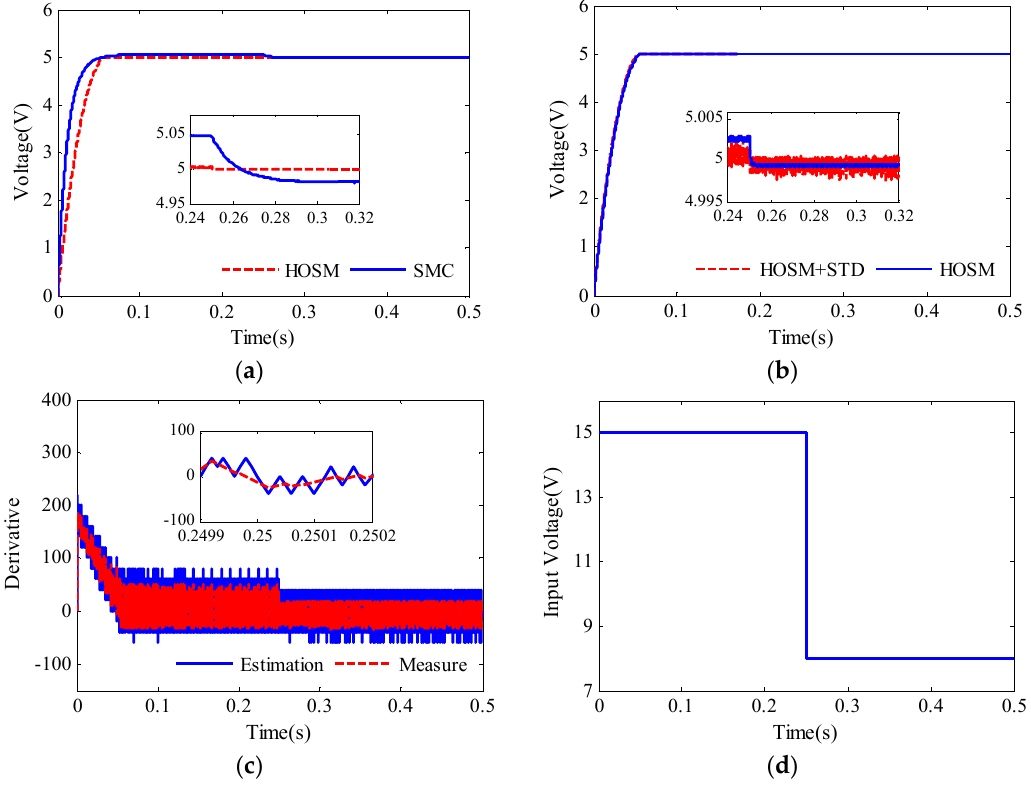
Figure 3. Simulation results for the buck converter under the perturbation in input voltage (step change from 15 to 8 V at 0.25 s), β = 70.2, k = 85. ( a ) Output voltage comparison between HOSM and SMC; ( b ) Output voltage comparison between HOSM + STD and HOSM; ( c ) Comparison between the measured and estimated derivative of the sliding mode variable d σ /d t ; ( d ) The input voltage. Table 3. Steady state performance analysis results.